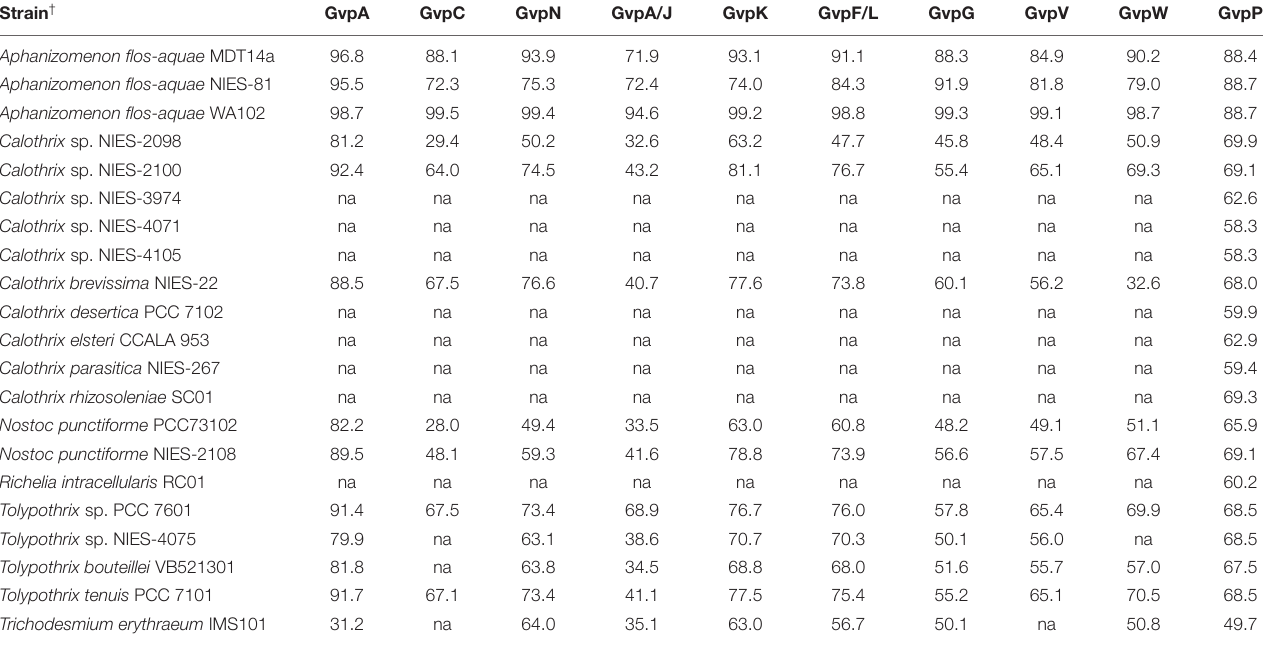
TABLE 5 | Similarities of gas vesicle structural proteins (Gvp) between cyanobacterial diazotrophs and Dolichospermum flos-aquae CCAP 1403/13F (GenBank: U17109.1) by BLASTp. Strain † GvpA GvpC GvpN GvpA/J